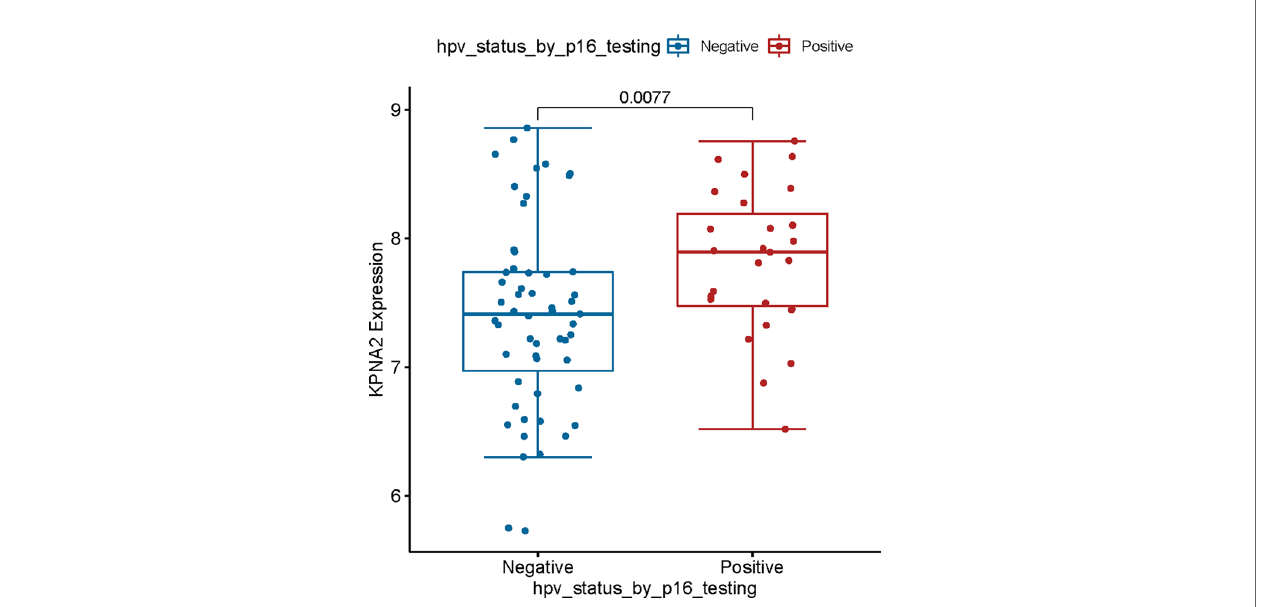
FIGURE 7 | Validation of the relationship between KPNA2 expression and clinical information. KPNA2 was up-regulated in patients with HPV-positive TSCC patients.